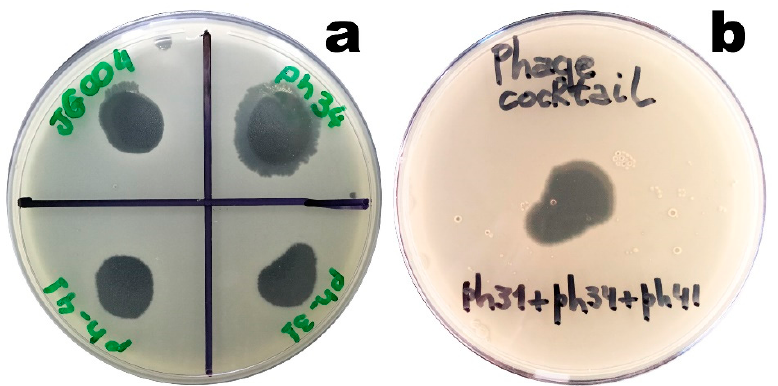
Figure 3. Results obtained following evaluation of the lytic activity of the isolated phage particles ph0031, ph0034, and ph0041, and a comparison with the lytic activity of phage JG004 obtained from the DSMZ collection ( a ) and of the lytic activity of the phage cocktail produced with the three isolated phage particles ( b ) on a P. aeruginosa DSM19880 bacterial lawn.